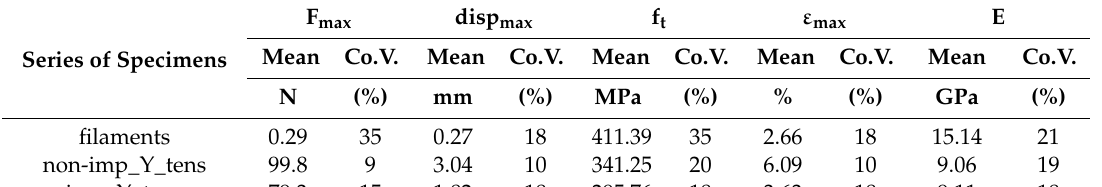
Table 2. Mechanical properties of specimens tested in tension.